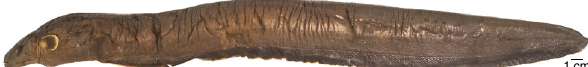
Fig. 5 Lateral view of Electrophorus electricus . National Museum of Natural History, NMNH 225670, 520 mm TL. Corantijn River, Suriname